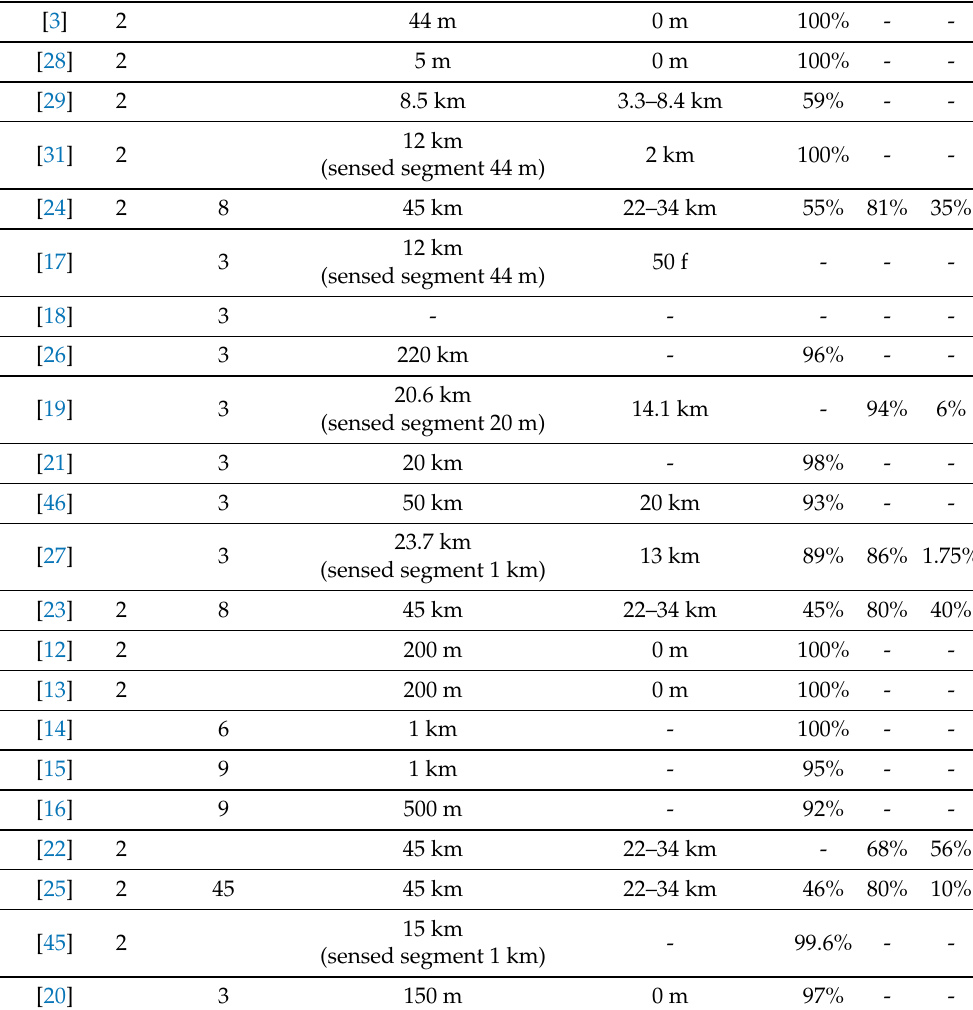
Table 9. Summary of the experimental procedures based on the number of classes in the system. ‘m’ stands for meters, ‘km’ for kilometers, ‘f’ for feet, ‘Acc.’ for accuracy, ‘TDR’ for true detection rate, and ‘FAR’ for false alarm